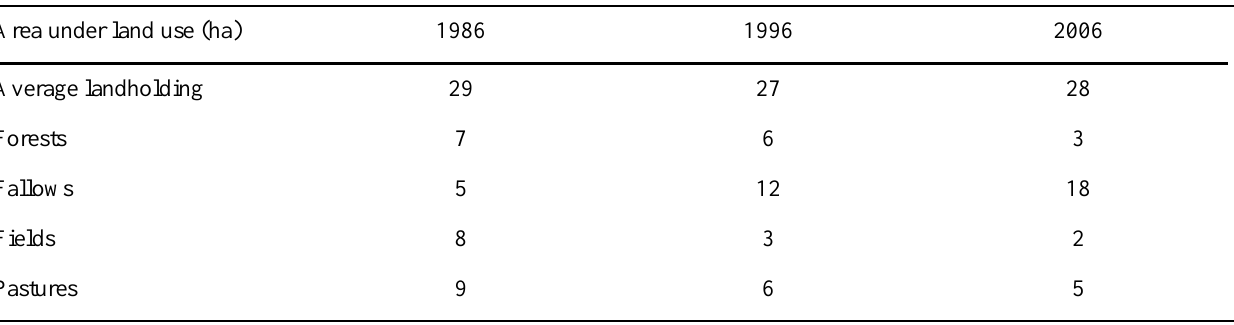
Table 1. Changes over 20 years in average area of four types of land-use units on 47 family landholdings near Contamana from 1986 to